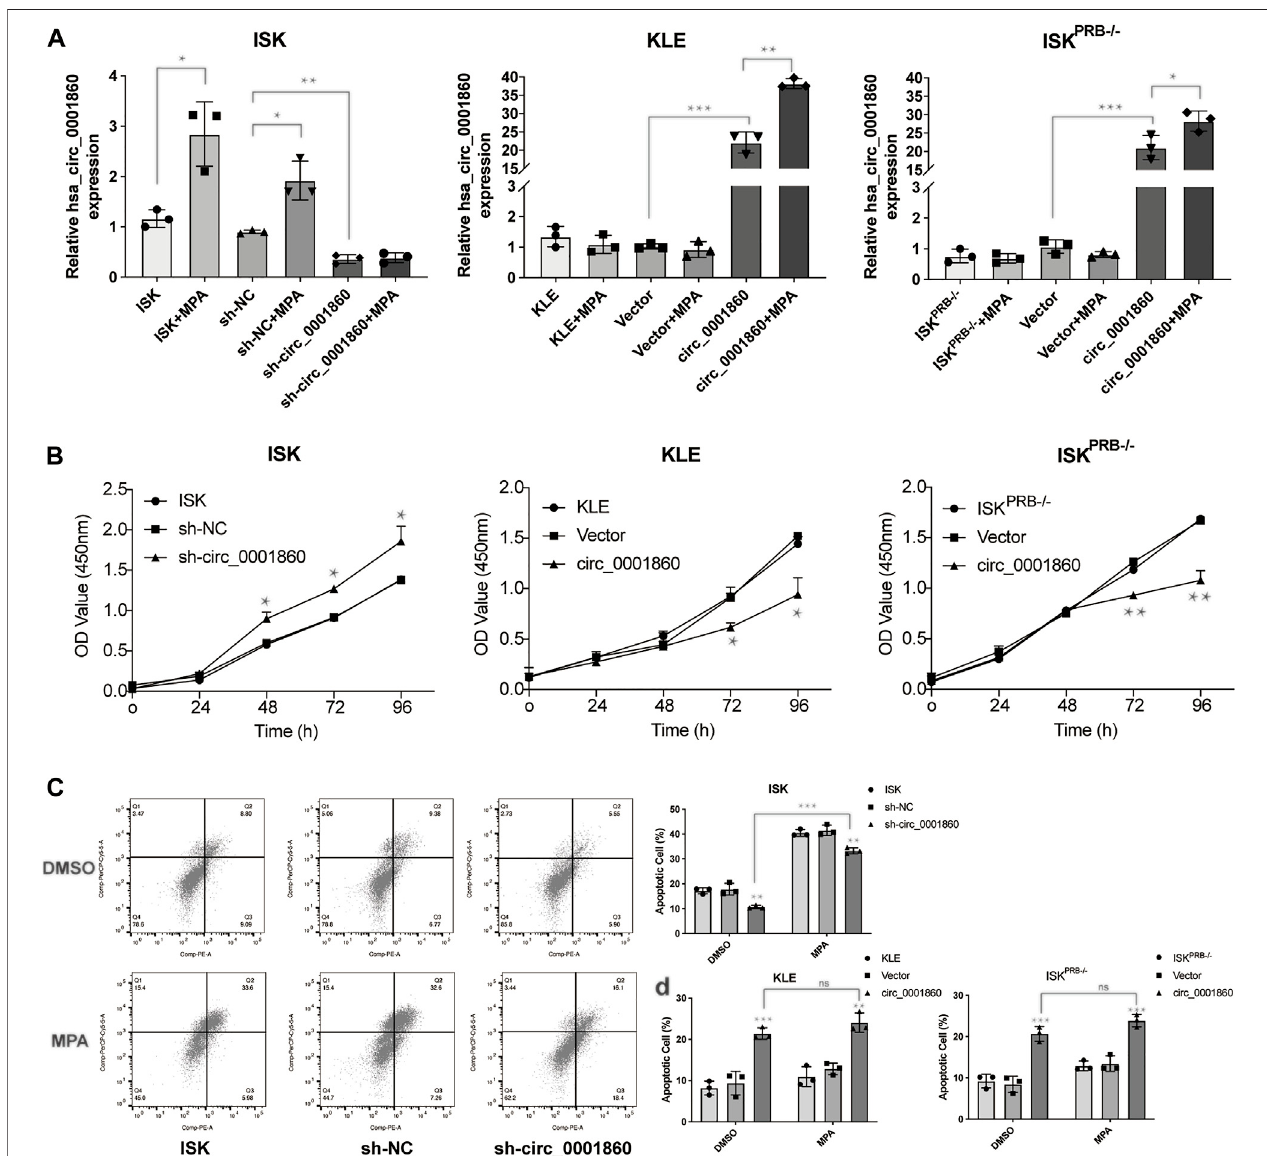
FIGURE 3 | The effects of hsa_circ_0001860 on proliferation and apoptosis of endometrial cancer cells. (A) qRT-PCR analysis of hsa_circ_0001860 in ISK, ISK PRB − / − ,andKLE(blankcontrol),transfectedwithsh-NC,sh-circ_0001860,vectorandcirc_0001860treatedwithDMSOorMPA. (B) Cellcountingkit-8(CCK8)assay was conducted to evaluate cell proliferation. (C,D) Cells were treated with MPA (10 μ M) or DMSO (control) and subjected to Annexin V-PE/7-AAD staining to detect apoptosis by fl ow cytometry. * p < 0.05, ** p < 0.01, *** p < 0.001.